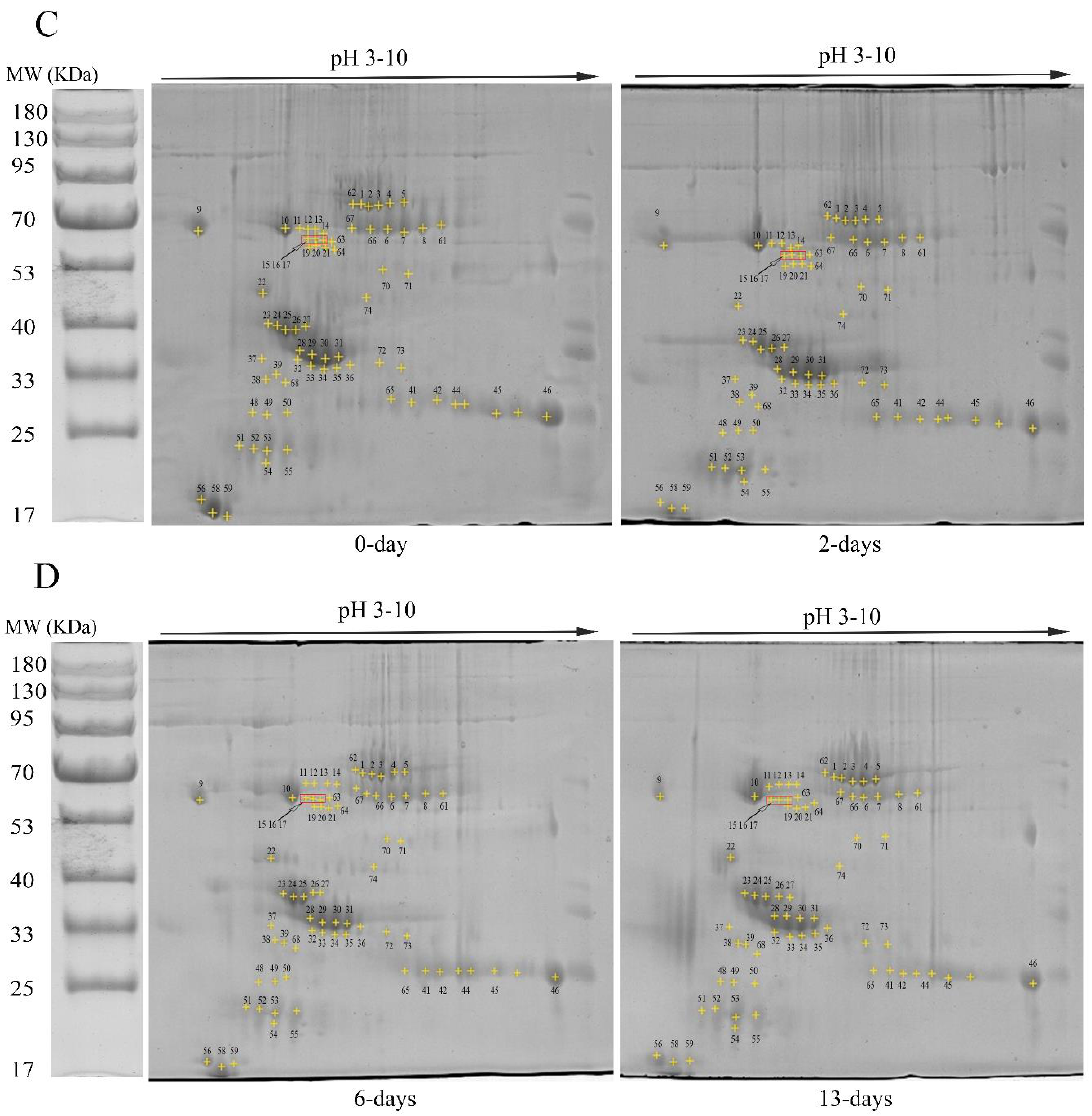
Figure 1. ( A – D ) Representative 2-D gel images of the low ( A , B ) and high cholesterol ( C , D ) eggs proteins after 0, 2, 6, and 13 days of embryonic development. The protein spots were separated by IEF/SDS-PAGE and gels were silver stained. The pI scales, incubation days, and MW are shown. Each gel is representative of three independent replicates.